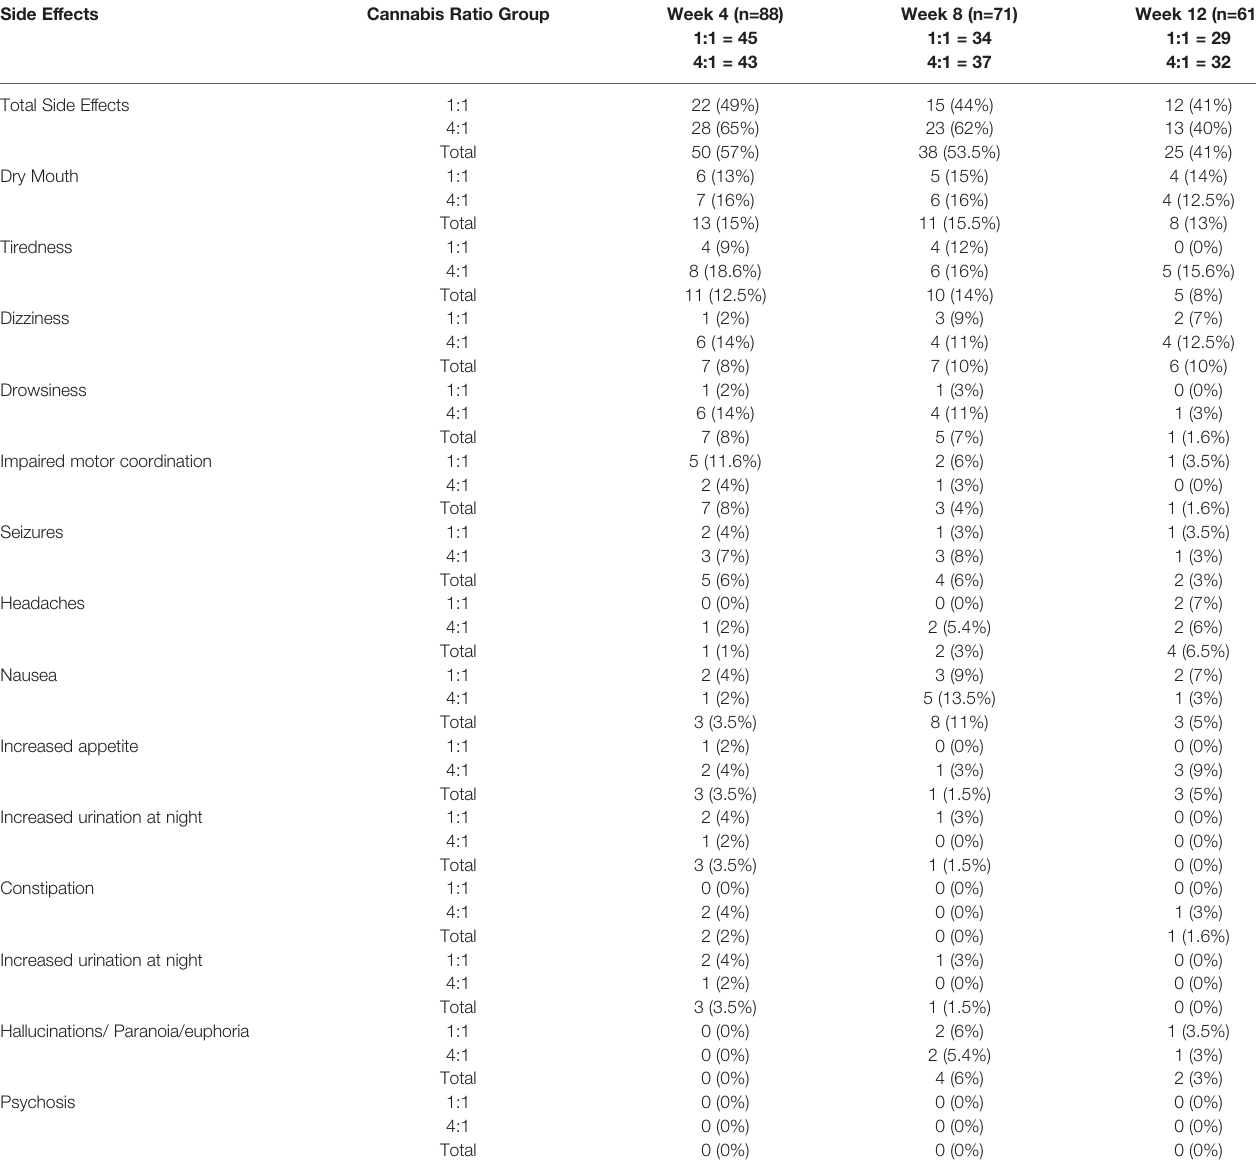
TABLE 6 | Side effects from the cannabis interventions as reported by the study participants. Side